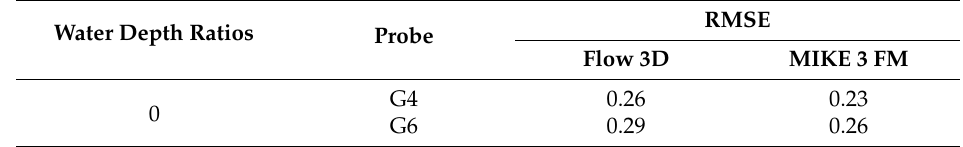
Figure 12. Average velocity for the dry ‐ bed at G4 (0.8 m) and G6 (1.2 m) by Khankandi et al. [39]. Table 4. RMSE values for the averaged velocity evolution at G4 and G6 based on experimental data by Khankandi et al.